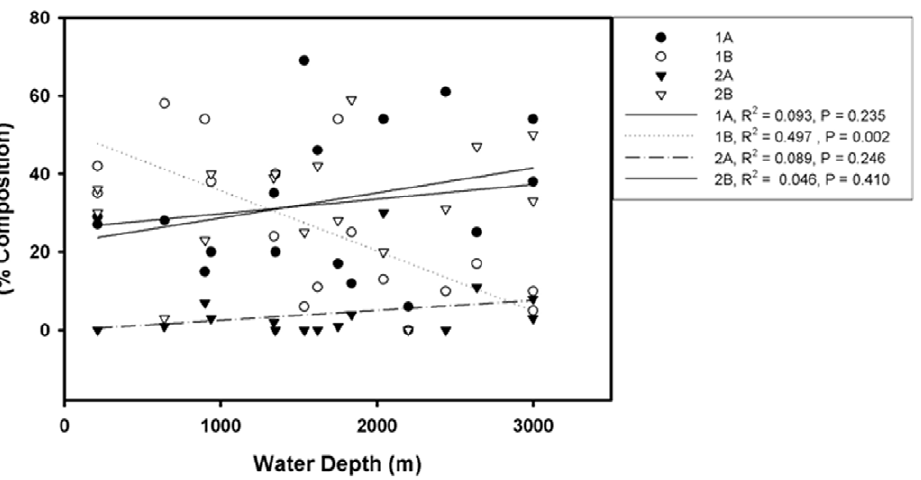
Figure 6. Relative composition of nematode feeding groups in meiobenthos samples of GOM.